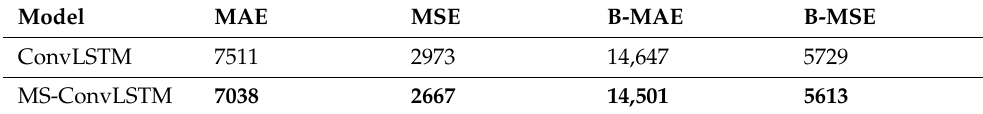
Table 1. Comparison of the prediction results of the two models. The best results are marked in bold. general, lower values for the evaluation metrics indicate better performance, but this can depend on the specific cases and the relative importance of different types of errors. Model MAE MSE B-MAE